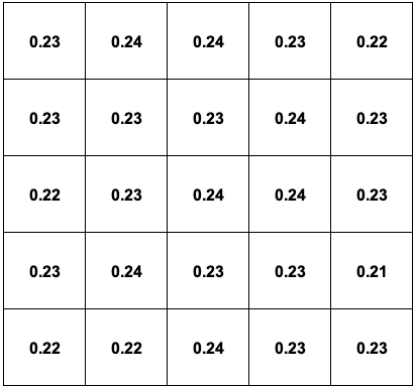
Figure 13. The peak-to-total efficiency ratio of each element, calculated as the ratio between the uncollimated count rates (left side) of Figures 11 and 12.